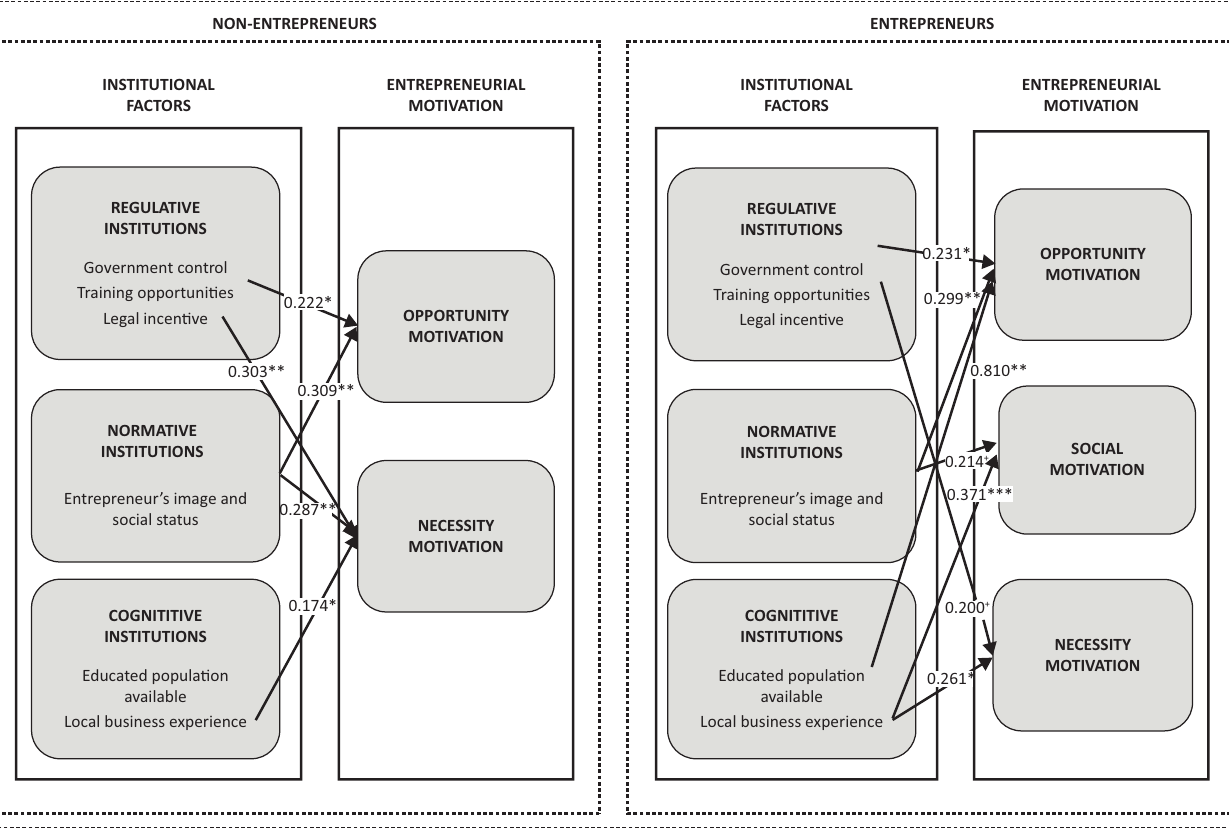
FIGURE 1: Influence of institutional perception on construction of entrepreneurial motivations.